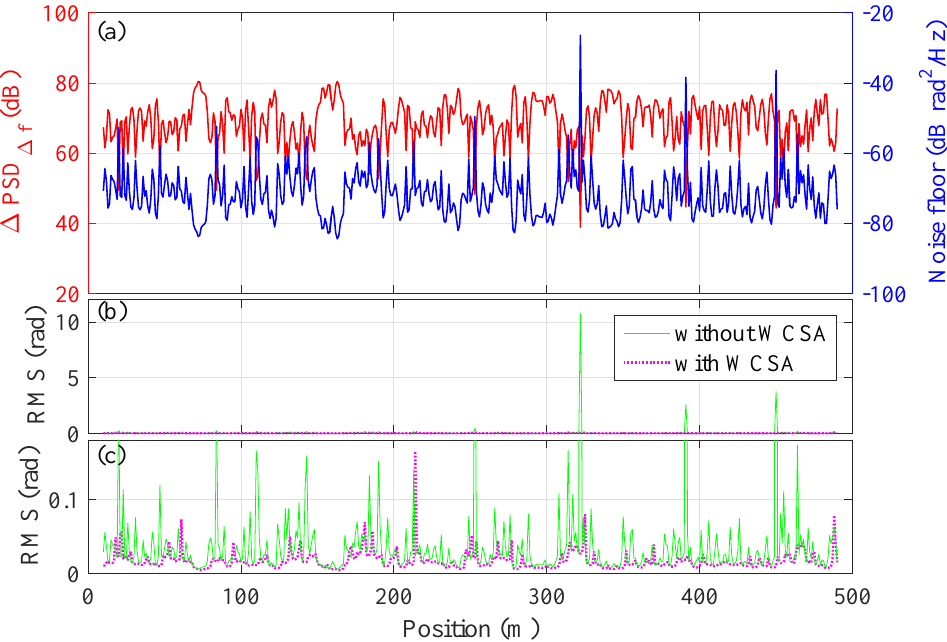
Figure 6. ( a ) the relative PSD at heterodyne frequency (left vertical axis) and the corresponding noise floor of the detected phase (right vertical axis) at different positions, showing a clear anti-correlation relation; ( b ) the RMS value of the detected phase over position without (green-solid) and with (magenta-dashed) WCSA; ( c ) zoom-in of (b) in vertical